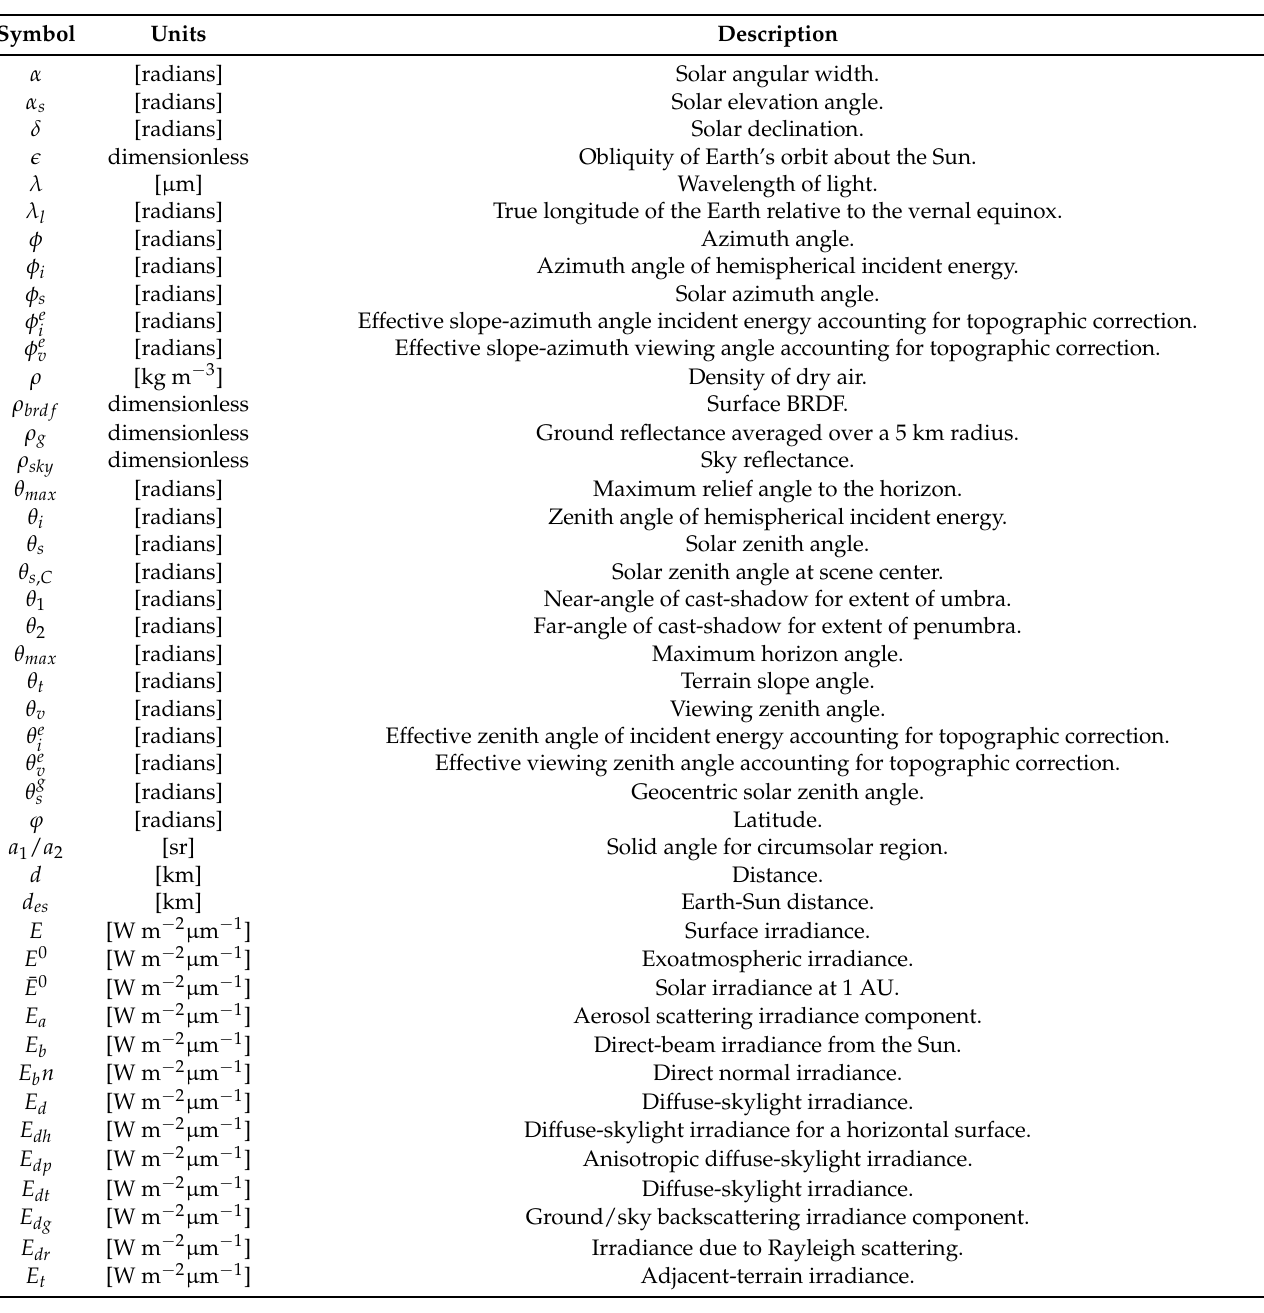
Table A1. Mathematical symbols used in radiation-transfer cascade